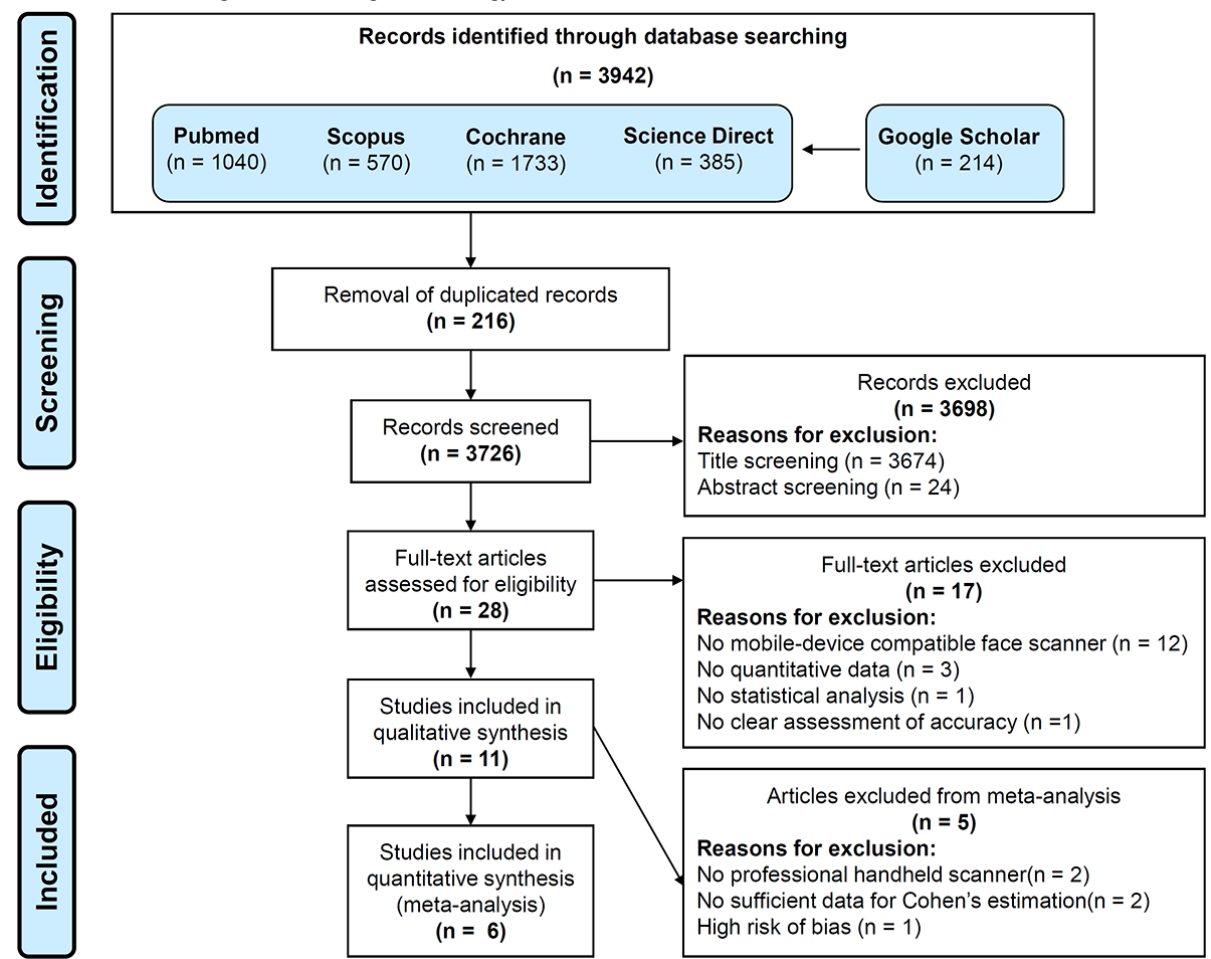
Figure 1. PRISMA flow diagram summarizing search strategy and search